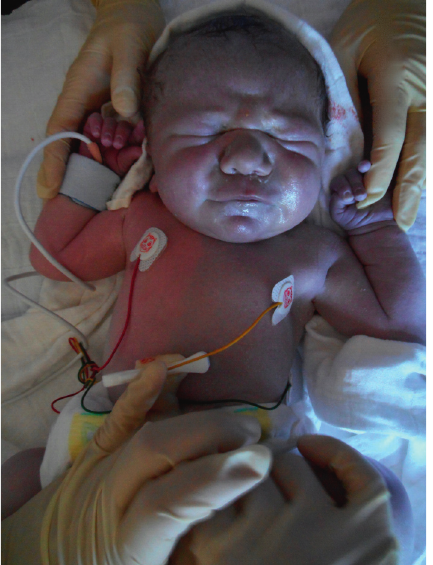
Figure 1: Clinical appearance of the patient during primary care showing marked differential cyanosis.